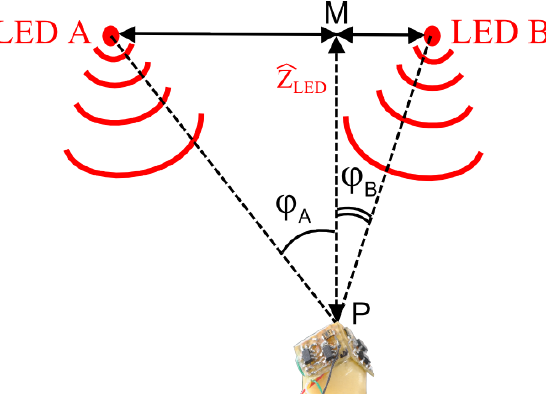
Figure 12. Height estimation description while HyperCube assesses the azimuthal angles ϕ and ϕ thanks to the signal output S A B